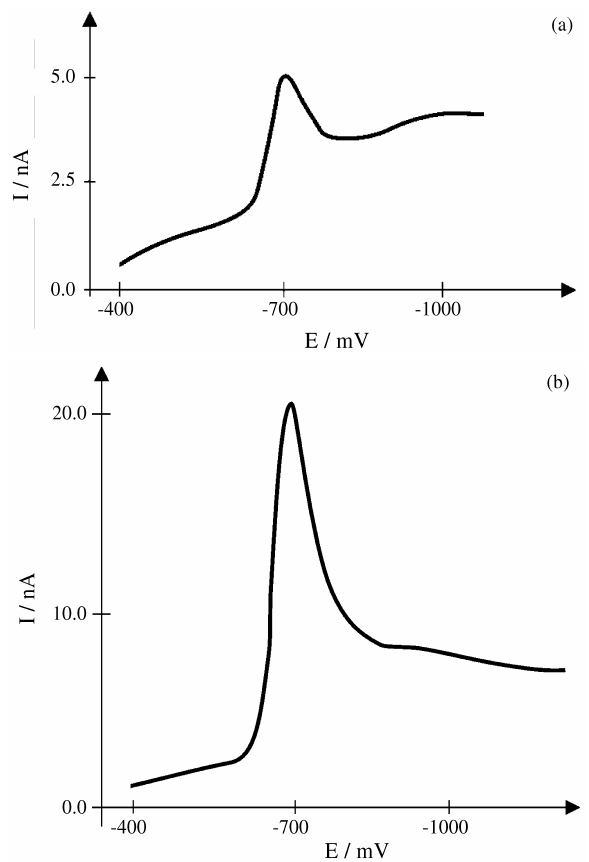
Figure1. Anodicstrippingvoltammogramsofadeaerated200 µ Lsample of Cd 2+ 10 mg L -1 solution in 10 mL of KCl 0.1 mol L -1 at pH 4.8 (a) after 90 min electrolysis and b) before electrolysis onto a RVC-PPy 0 electrode.